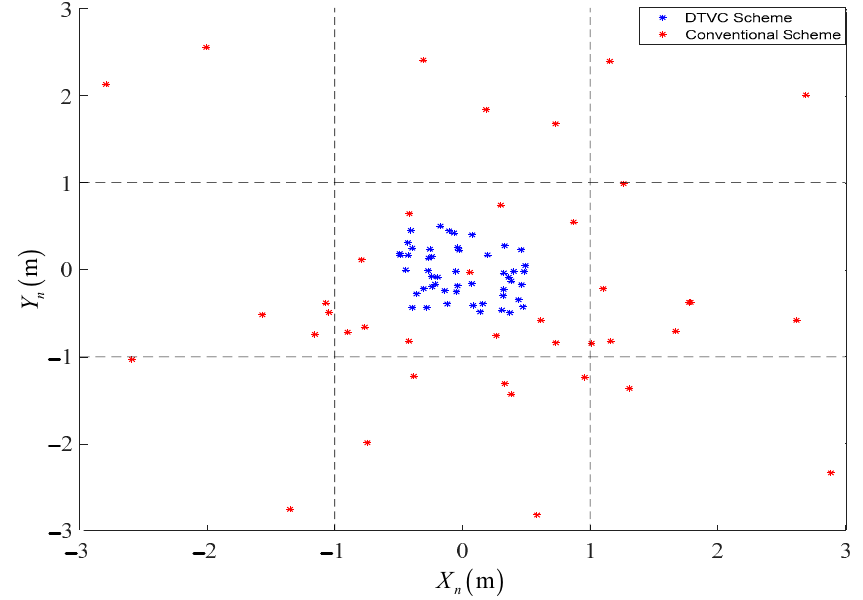
Figure 17. The statistical results of the landing locations for the two schemes.